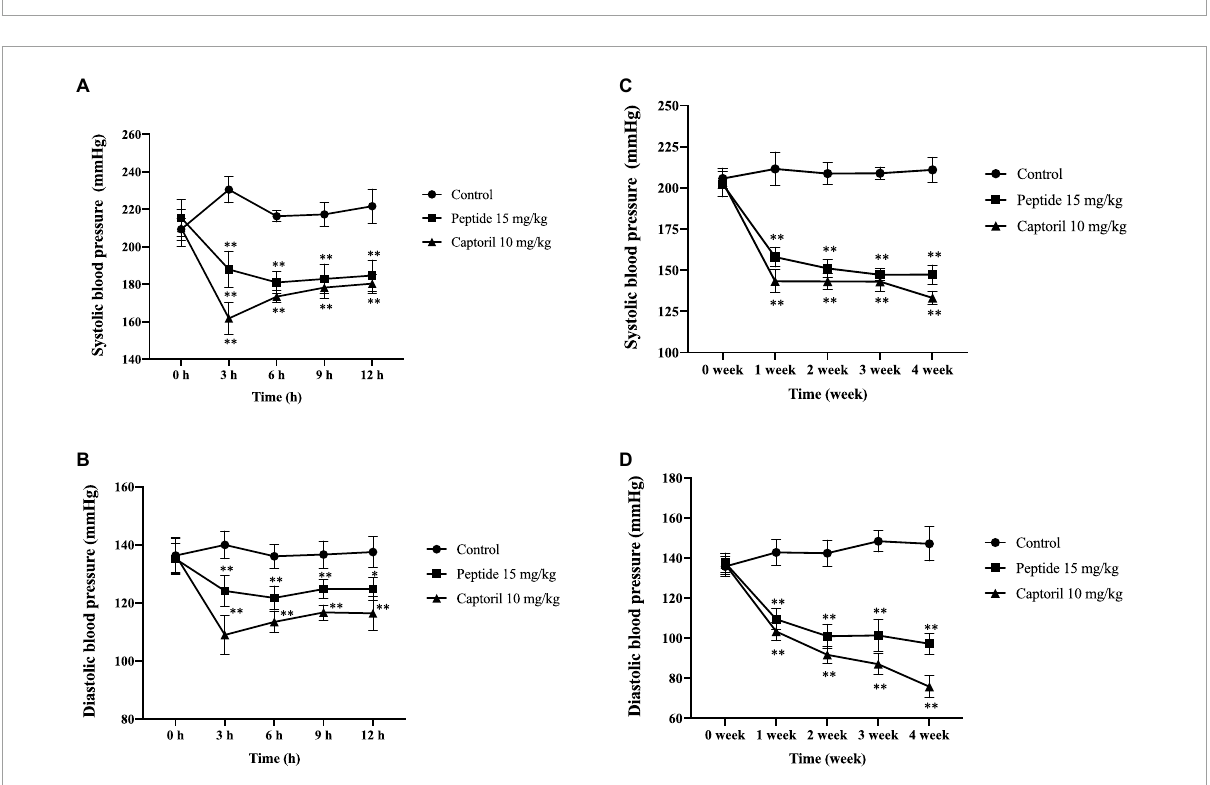
FIGURE3 Effect of AEYLCEAC on blood pressure of SHRs’ rats after single and continuous administration. (A) SBP after a single intragastric administration to all groups. (B) DBP after a single intragastric administration to all groups. (C) SBP after continuous intragastric administration to all groups. (D) DBP after continuous intragastric administration to all groups. All data are present as the mean ± SE. ∗ p < 0.05, ∗∗ p < 0.01.